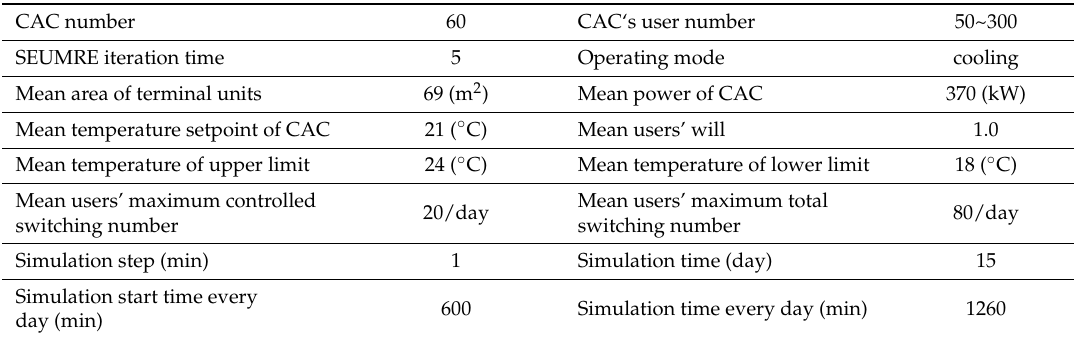
Table 1. Basic Simulation Parameters.